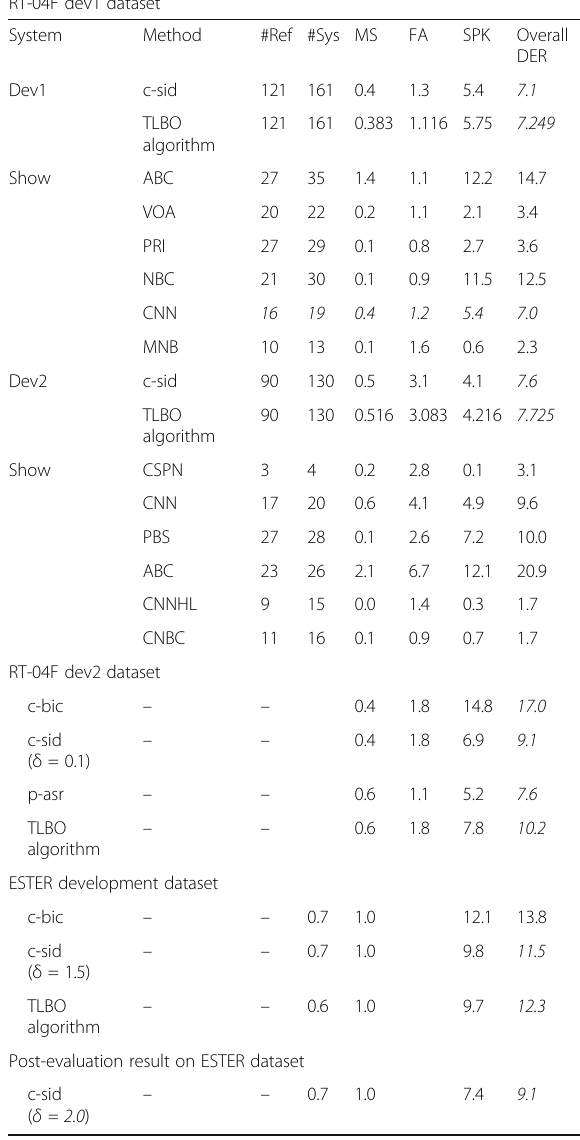
Table 9 Performance results of TLBO algorithm, c-bic , c-sid, and p-asr systems obtained on the RT-04F and ESTER datasets. Scores are given for missed speech (MS), false alarms (FA), speaker errors (SPK), and overall diarization error rate (DER). #REF and #Sys are, respectively, the reference and system speaker